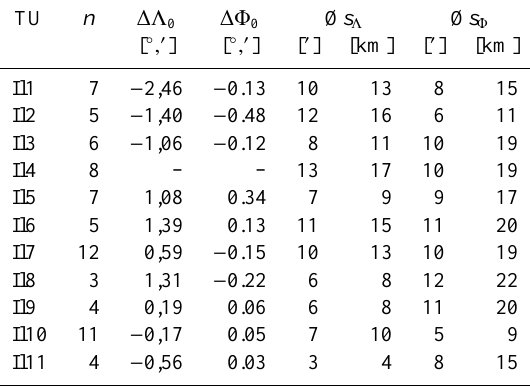
Table 1. Illyricum : transformation units (TU); number of places n ; relative shifts ∆Λ 0 , ∆Φ 0 with respect to Il4; average ancient coordi- nate accuracies Ø s Λ , Ø s Φ